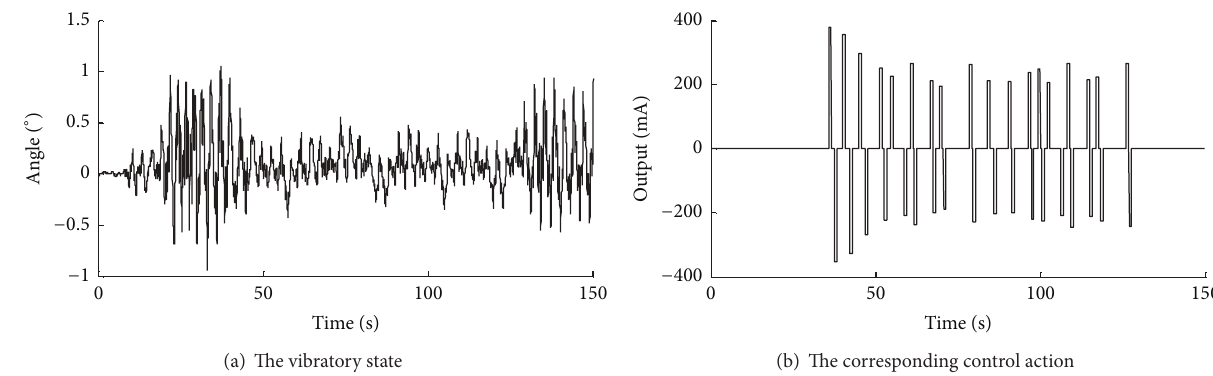
Figure 11: Experimental results of the fourth boom with and without constant-position CIST under periodic disturbances.